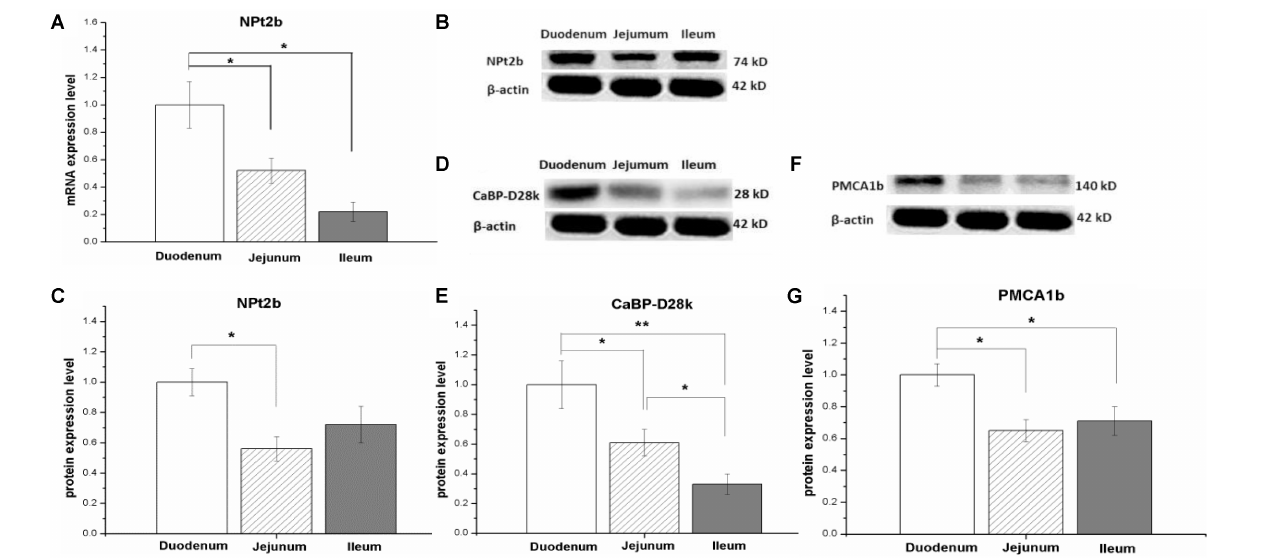
FIGURE 1 | The mRNA and protein expression level of calcium and phosphorus transporters in small intestinal tract of laying hens fed with control diet (0.41% AP). The type II-B Na/Pi and co-transporter (NPt2b) in small intestine (A–C) ; the protein expression level of Calbindin-D28k (CaBP-D28k) (D,E) ; the protein expression level of plasma membrane calcium ATPase 1b (PMCA1b) (F,G) . Data were presented as means ± SEM ( n = 8); ∗ P < 0.05, ∗∗ P <